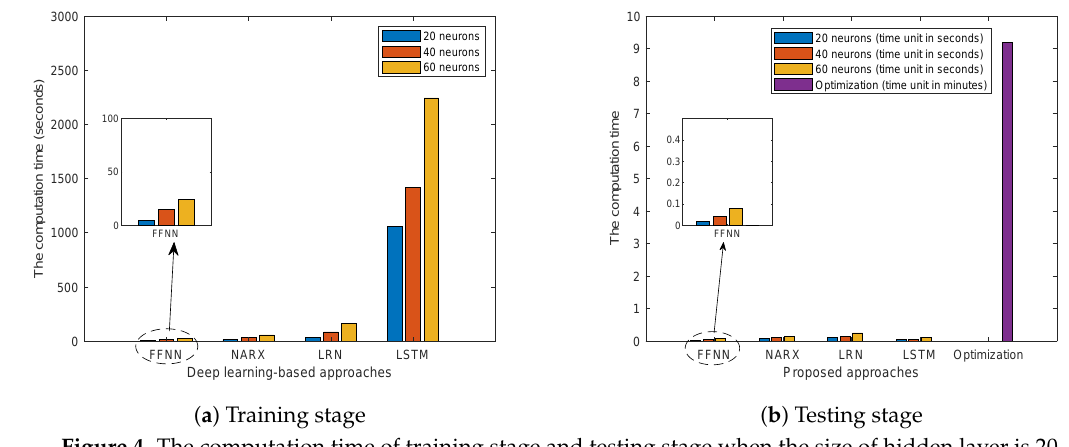
Figure 4. The computation time of training stage and testing stage when the size of hidden layer is 20, 40, and 60 neurons, respectively: ( a ) Computation time among FFNN, NARX, LRN and LSTM in the training stage. ( b ) Computation time among FFNN, NARX, LRN, and LSTM and optimization scheme in the testing stage.